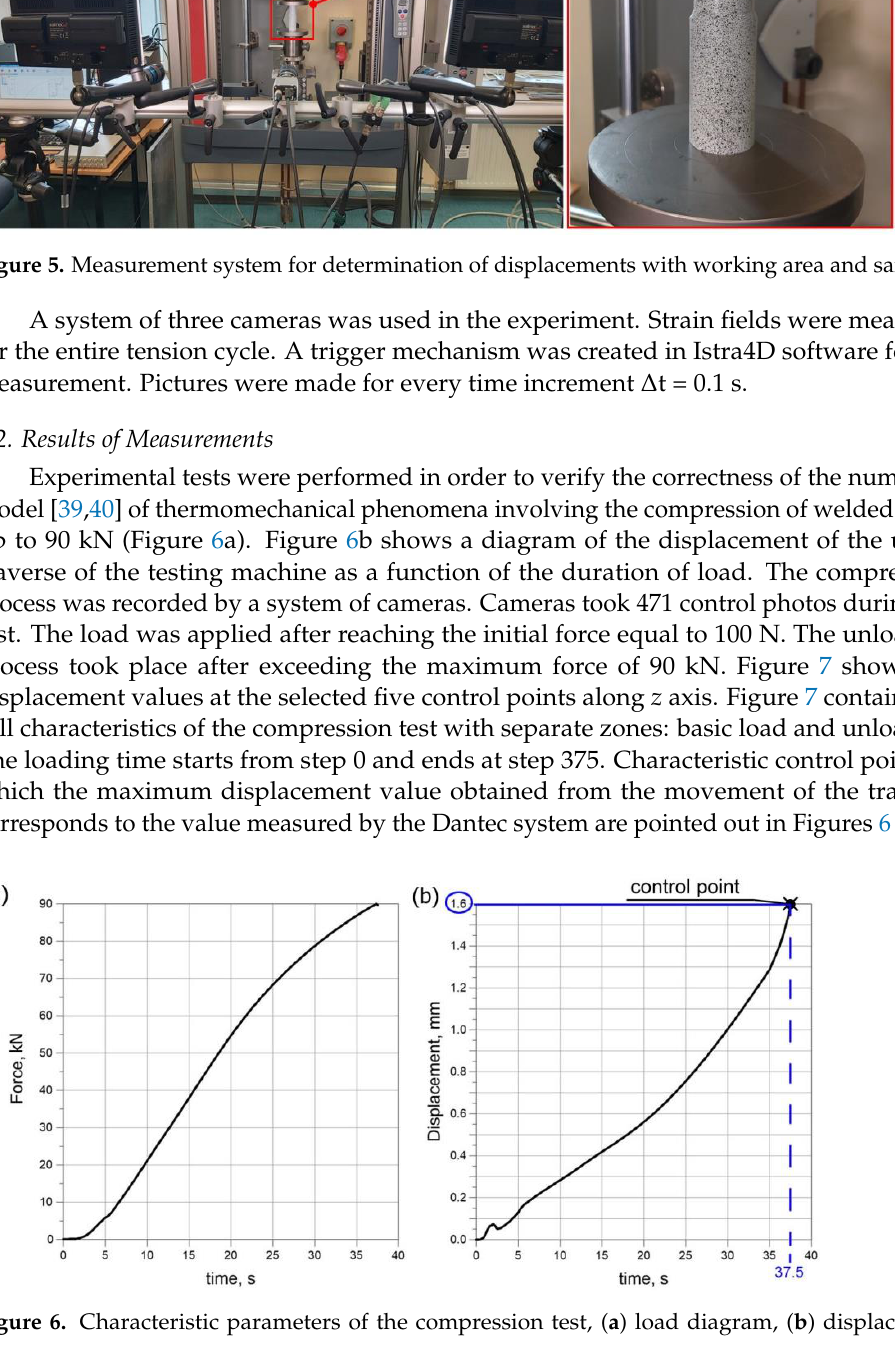
Figure 7. U z displacement diagram for five selected measuring points. Figure 8a shows the displacement field along the z axis (the axis compliant with the loading direction), where the measurement line is marked as a solid line. For this line, the displacement diagram is shown in Figure 8b. The measuring line is on the side surface of welded pipes. It can be observed that in the area of the weld; the displacements have much lower values compared to the base material, which is related to the increase in stiffness of this area, resulting from the change of mechanical properties of the weld.